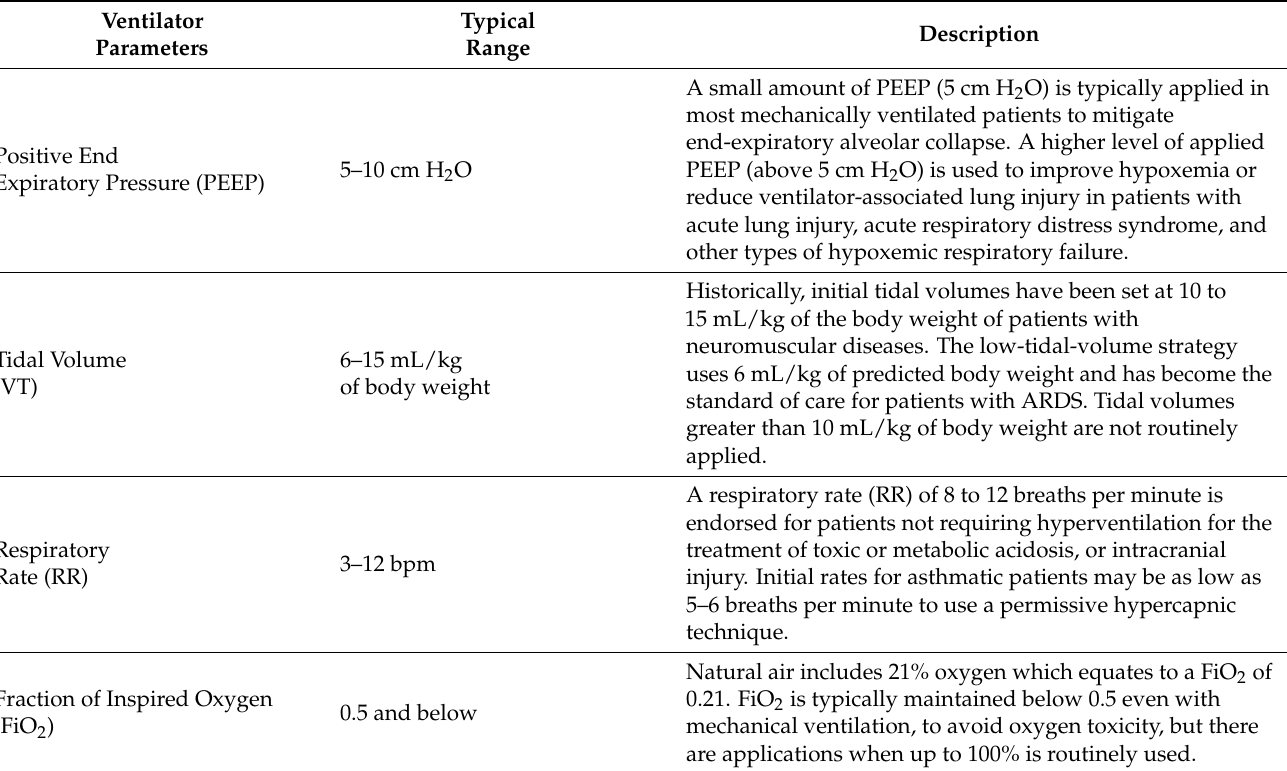
Table 3. The typical boundaries for mechanical ventilator